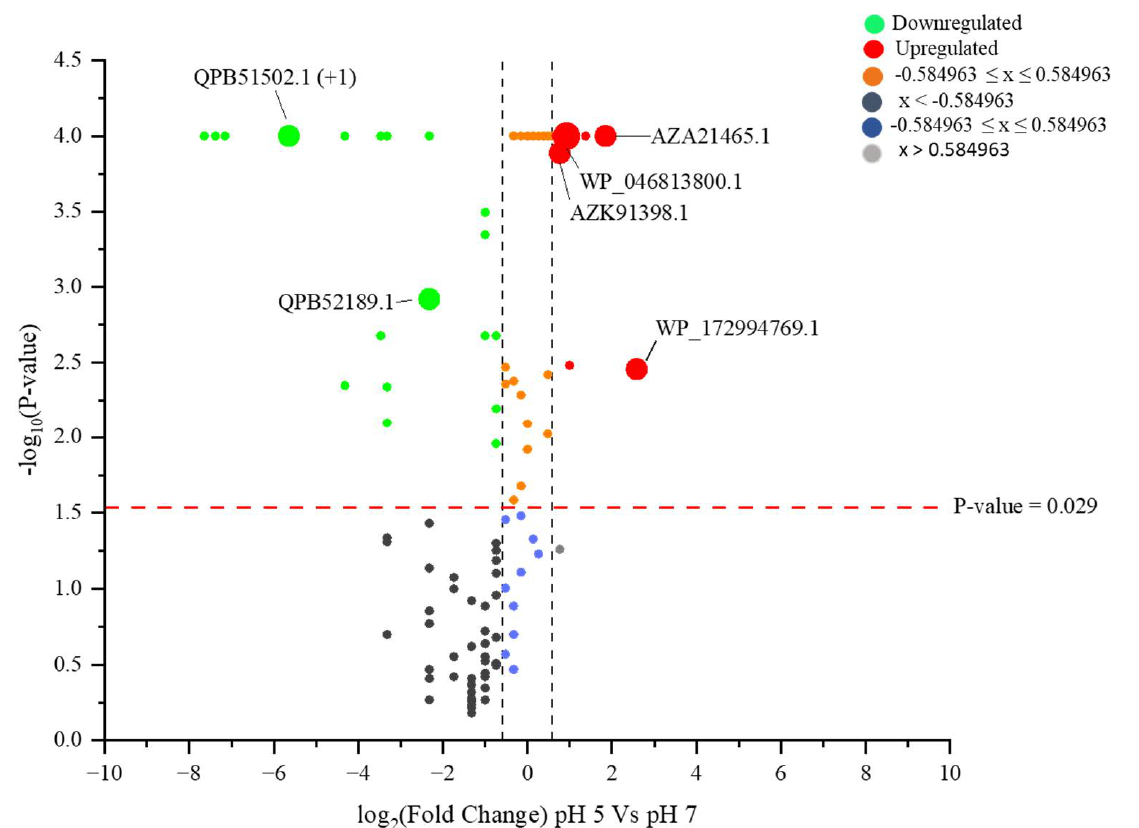
Figure 3. Volcano plot illustrating the distribution of differentially quantified proteins from L. helveticus CFS as − log10 (Benjamini–Hochberg-adjusted p -values) plotted against log2 (fold change) for pH 7 vs. pH 5. The non-axial black dotted vertical lines represent a ± 1.5-fold change, while the horizontal red dotted line indicates the significance threshold (before logarithmic transformation) at p ≤ 0.029.